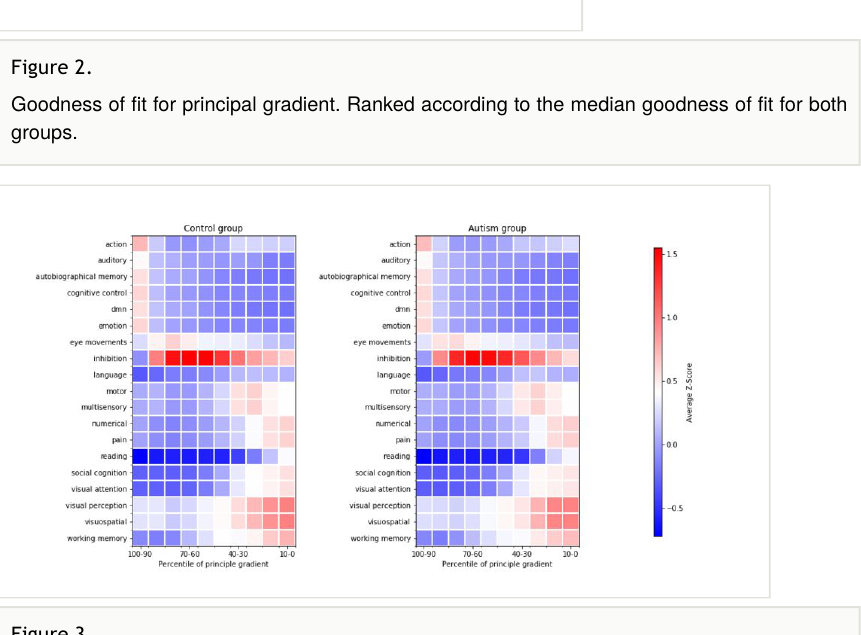
Figure 3. Average z-scores obtained from unthresholded reverse-inference neurosynth meta-analysis activation maps. We divided the principle gradient into percentiles and used this to create a mask. We then calculated the average z-score inside this mask on neurosynth